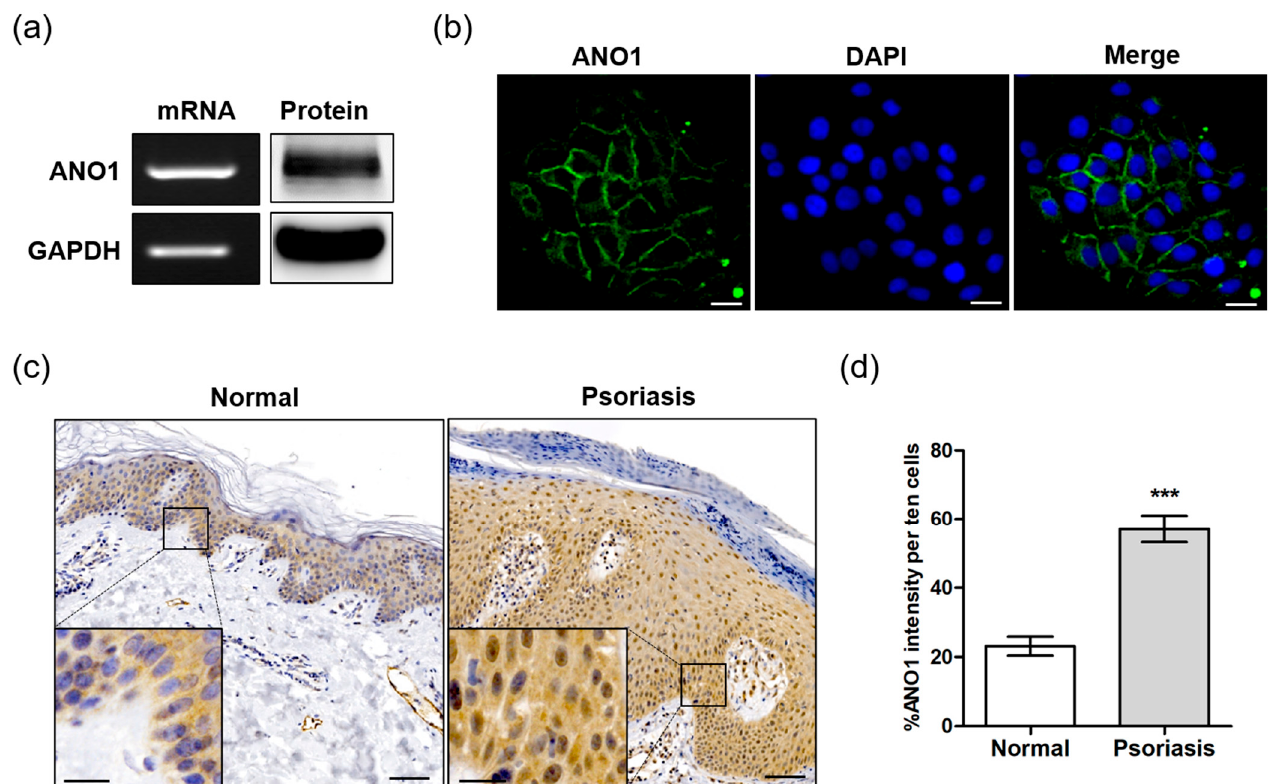
Figure 1. Expression of ANO1 in the human keratinocyte HaCaT cell line and psoriatic tissue. ( a ) The expression of ANO1 mRNA and protein levels in HaCaT cells. ( b ) Expression of ANO1 protein in HaCaT cells using immunocytochemistry. Scale bar = 50 µm. ( c ) The expression of ANO1 protein in psoriatic skin tissue was increased compared to that of healthy skin tissue. Scale bar = 50 µm (insert: 20 µm). ( d ) Expression of ANO1 in the skin of normal and psoriasis from immunohistochemical analysis (ANO1 intensity of ten cells per unit area was measured using ZEN 3.1). To compare the differences of ANO1 expression between normal and psoriasis skin tissues, Student’s t -test was used. *: significantly different from normal skin (*** p < 0.001).